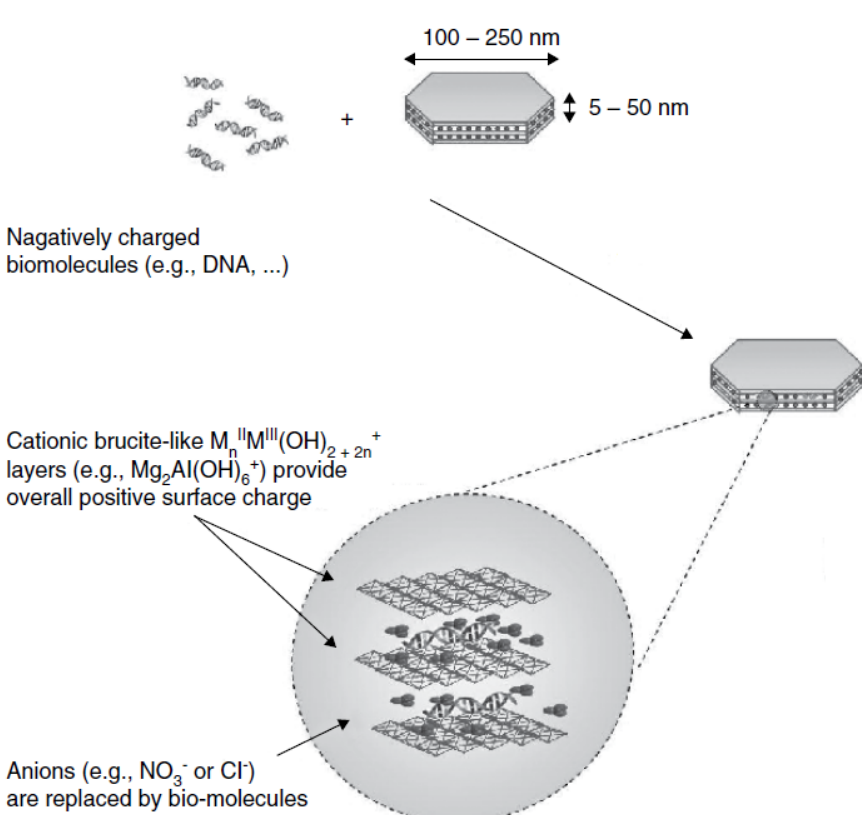
Figure 1. The intercalation mechanism of oligonucleotides with LDH nanoparticles. (Reproduced with permission from Katharina Ladewig et al.